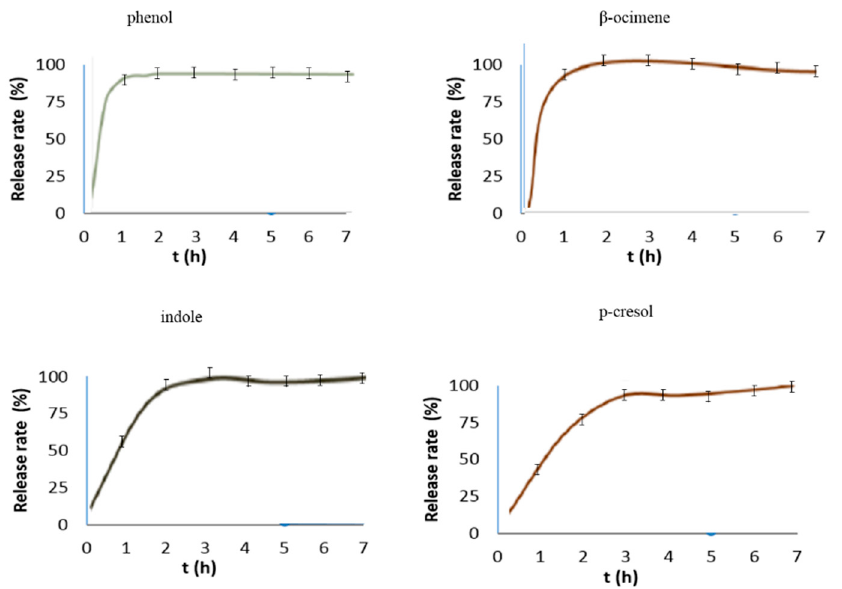
Figure 9. Controlled release rates of the bioattractants from microencapsulated product. Profiles obtained revealed that each bioattractant showed different release rates over time. After three hours, a maximum release has been reached. After that time, a plateau was achieved. In view of these results, a sustained release is achieved over time, which promises good attraction